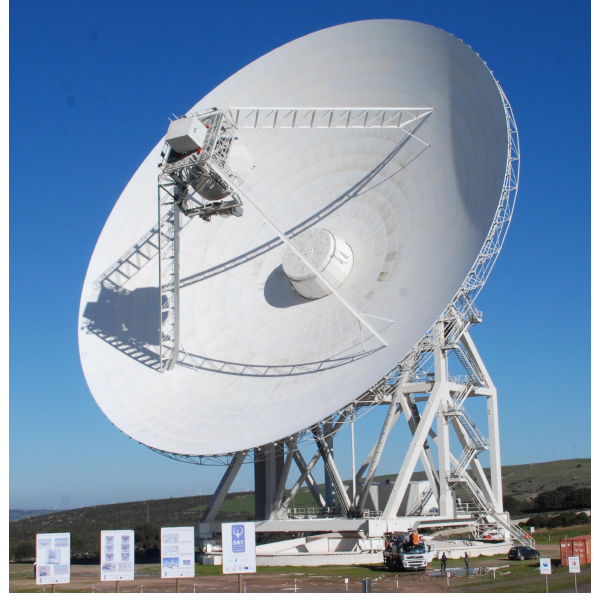
Figure 1: The Sardinia Radio